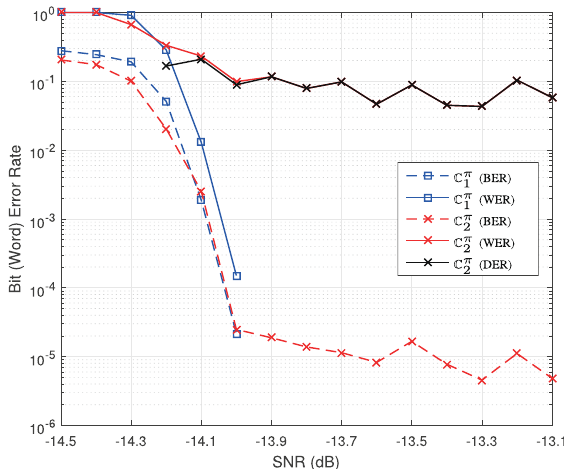
Fig. 3 BER and WER comparison between the punctured code of existing MET-LDPC code and optimized MET-LDPC code. By puncturing the MET-LDPC codes, i.e., C 1 and C 2 in Fig. 2, two rate-compatible MET-LDPC codes of rate 0.025 (equivalently, π = 0.2) are implemented and evaluated in terms of BER and WER on the BI- AWGN channel. The rate-compatible MET-LDPC codes based on C 1 and C 2 are denoted by C π and C π , 1 2